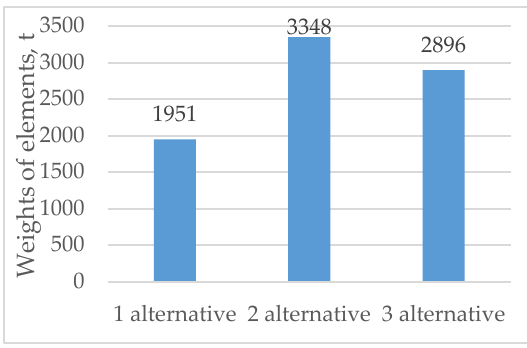
Figure 8. Comparison of weights of alternative load bearing structures (t).